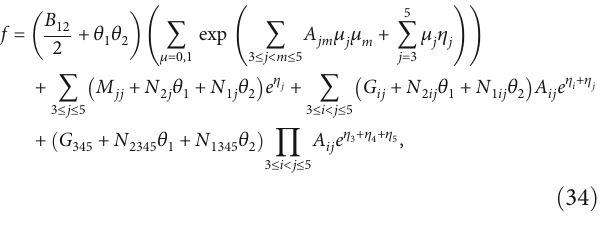
Figure 12: (a) Breather-soliton molecule in β 0 Breather-soliton molecule in β 0 1 = 10 , β 0 2 = 10 , and β 0 3 = − 10